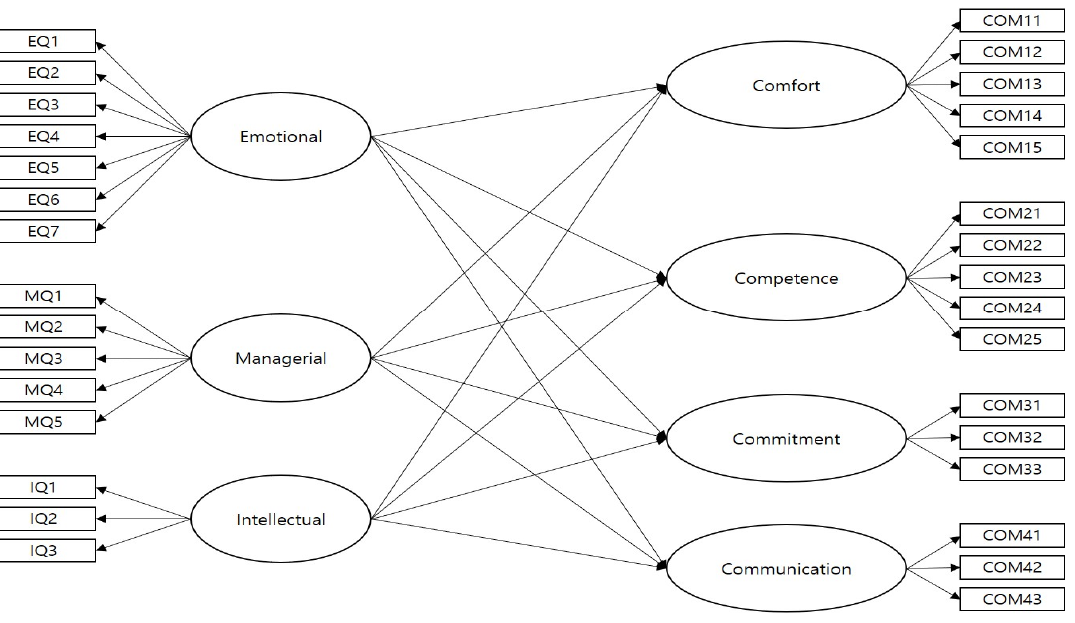
Figure 1. Research model.